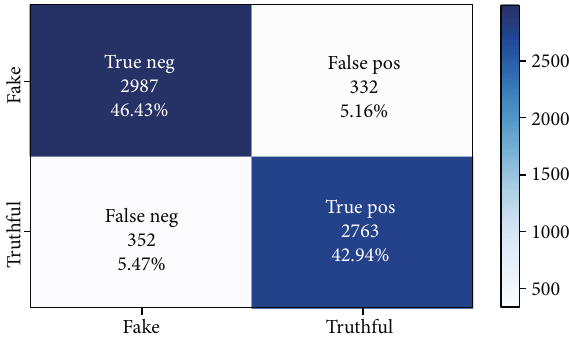
Figure 9: Confusion matrix for cross-domain